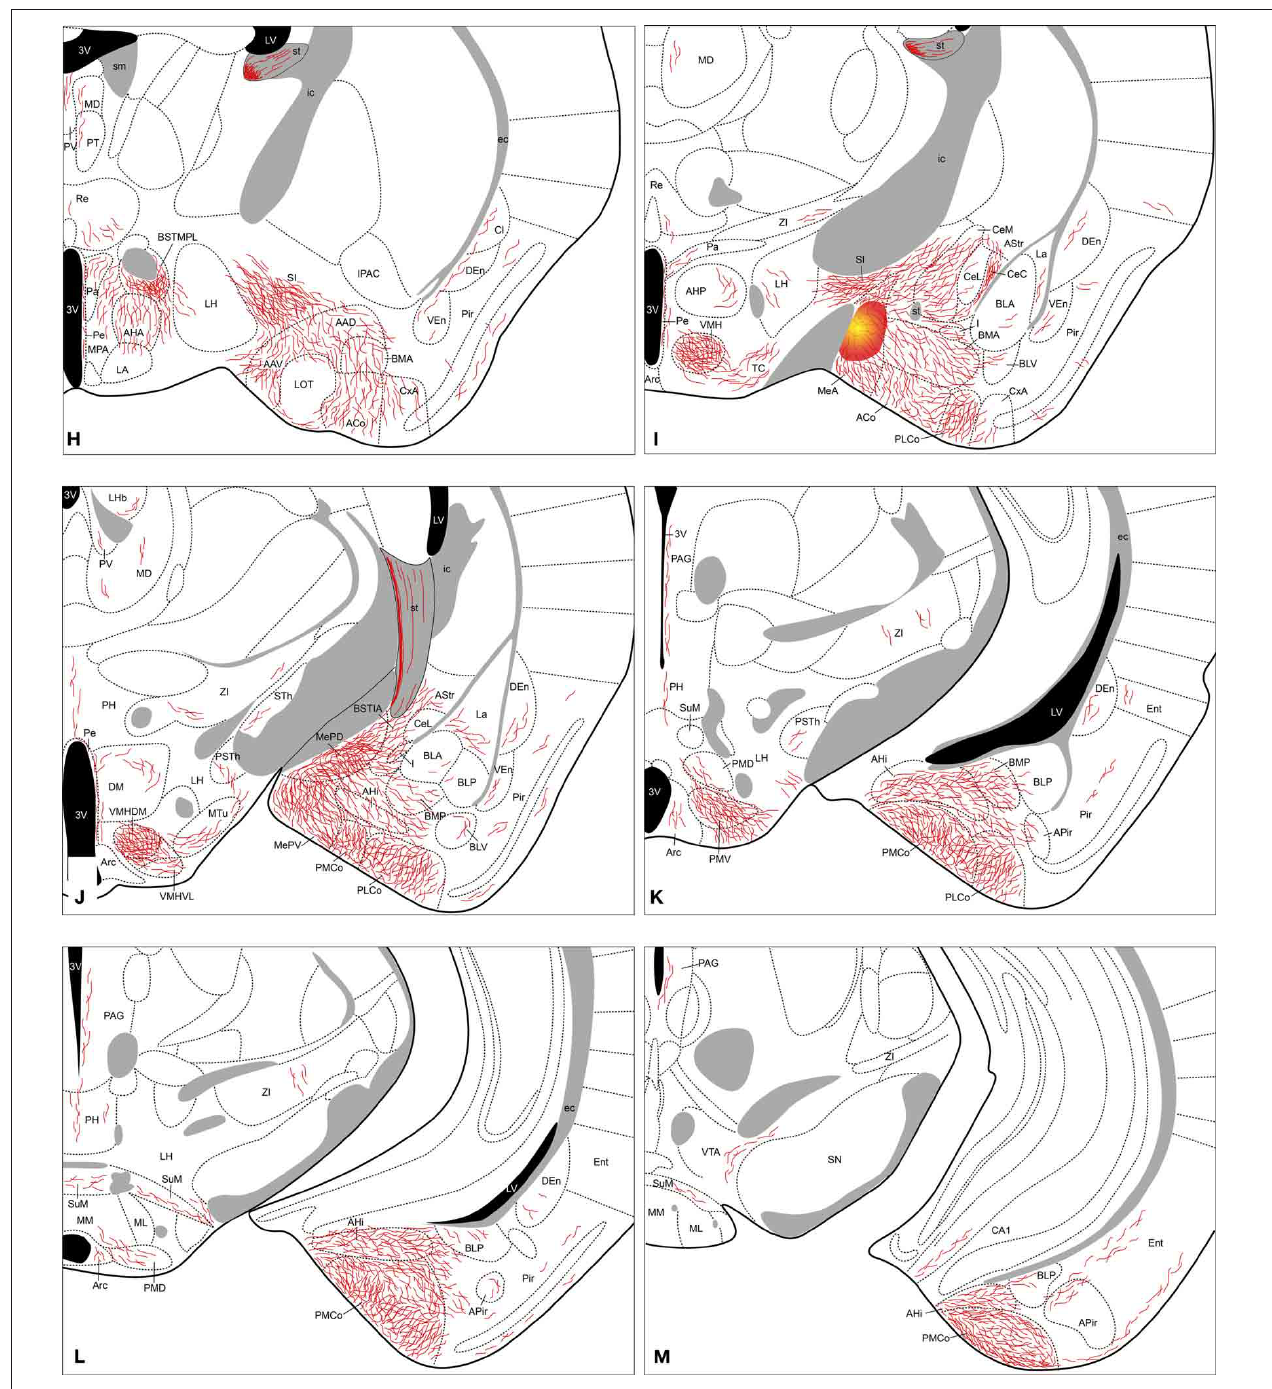
FIGURE 2 | Semi-schematic drawings of transverse sections through the mouse brain showing the distribution of anterogradely labeled fibers following a tracer injection in the MeA. The injection site is depicted in